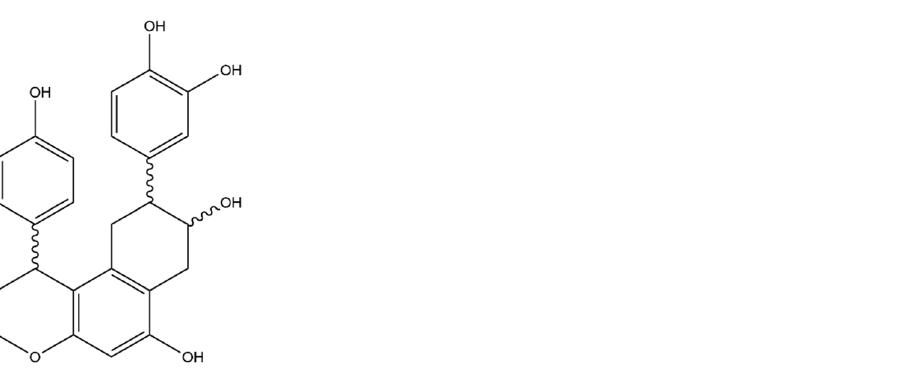
Figure 8. Structure of the identified lignans (compounds 31a and 31b ) cinchonain I isomers.